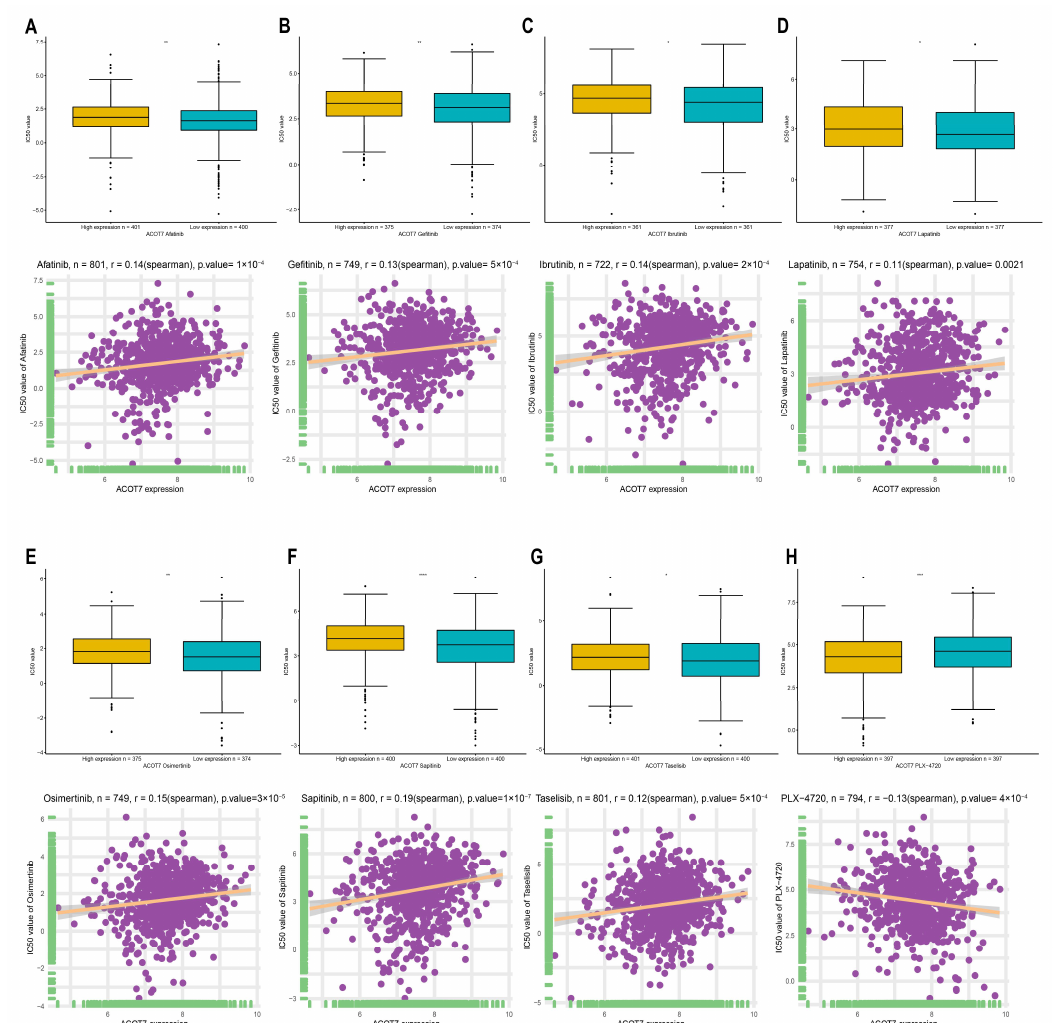
Figure 10. Spearman’s correlation between ACOT7 expression and drug sensitivity of ( A ) afatinib, ( B ) gefitinib, ( C ) ibrutinib, ( D ) lapatinib, ( E ) osimertinib, ( F ) sapitinib, ( G ) taselisib, and ( H ) PLX-4720. The comparison of IC50 concentrations between differential expression of ACOT7 were conducted using t -test. * p < 0.05, ** p < 0.01, *** p < 0.001, **** p < 0.0001.